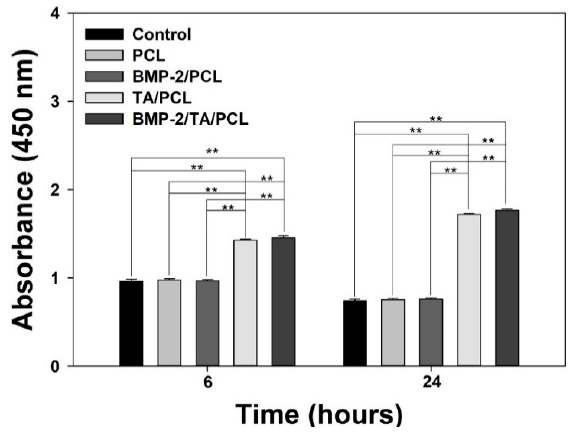
Figure 6. Cell viabilities of MC3T3-E1 cells grown on PCL, TA/PCL, BMP-2/PCL, and BMP-2/TA/PCL at 6 h and 24 h after the cells were pre-treated with 300 µM H 2 O 2 . Error bars represent mean ± SD, ** p <